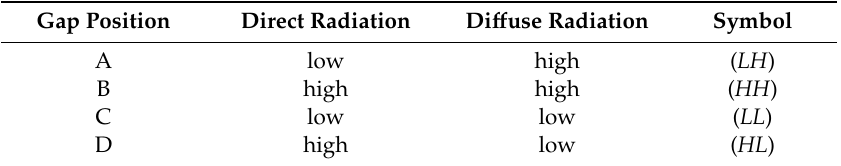
Table 1. Definition of four light regime classes in a gap (A–D) according to the relative availability of direct and di ff use radiation after Diaci [38]. Gap Position Direct Radiation Di ff use Radiation Symbol low